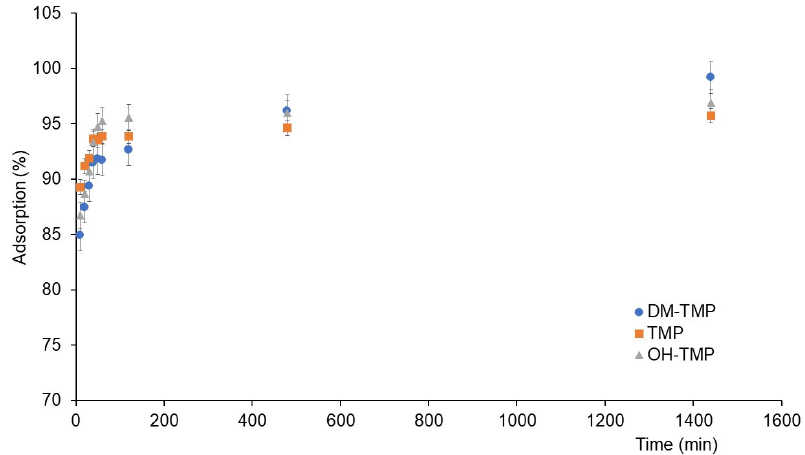
Figure 1. Adsorption kinetic of TMP and its metabolites. Table 1. Experimental kinetic adsorption parameters isotherms of TMP and its metabolites in